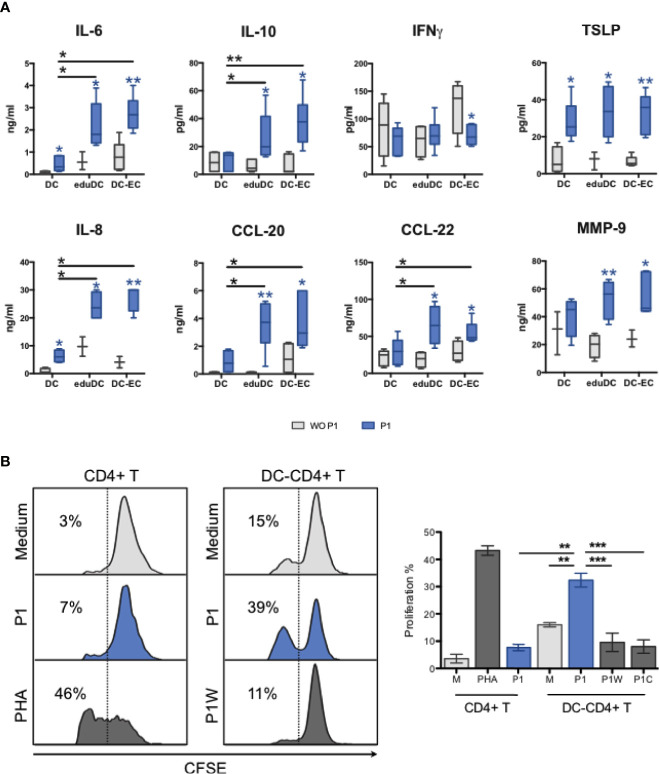
P1 stimulation of mucosal DCs results in CD4+T cell proliferation. (A) Cytokine and chemokine production of P1-treated DC models. IL-6, IL-10, IFNg, TSLP, IL-8, CCL-20, CCL-22, and MMP9 were quantified by a multiplex Luminex assay. The blue star (*) indicates significant differences (p values <0.05, student’s t-test) in each model between P1 (blue bars) and mock (gray bars) treatments, whereas the black star (*) compares P1-treated cells in different models. Data are presented as box-and-whisker plots from n > 3 independent experiments, p values <0.05, paired student’s t-test). (B) P1-treated mucosal DCs stimulate the proliferation of CD4+ T cells. CD4+ T cell proliferation was determined by flow cytometry according to CFSE intracellular concentration. Data are represented as proliferating CD4+ T cells as % of total CD4+ T cells. Phytohaemagglutinin (PHA) was used as positive control. Data are presented as mean ± SEM (n > 3 independent experiments; paired student’s t-test *p < 0.05, **p < 0.01, ***p < 0.001).